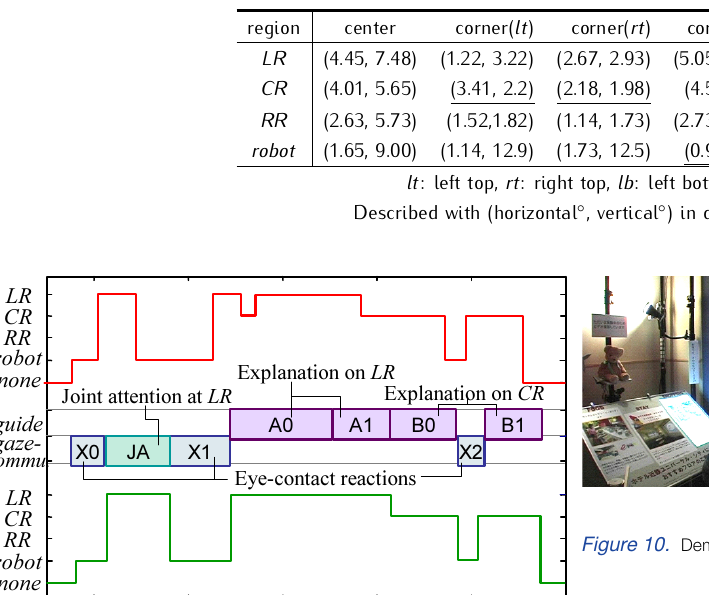
Table 2. Detailed Accuracies of Gaze-tracking for Each Region